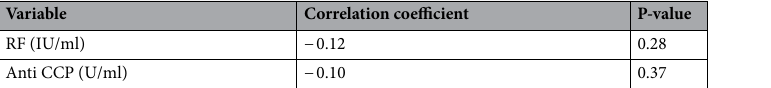
Table 5. Association between LAGLS and inflammation related indexes in RA patients. RF rheumatoid factor, Anti CCP anti-cyclic peptide containing citrulline.